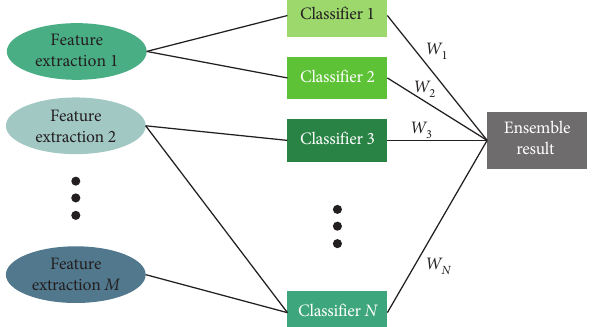
Figure 9: Improved feature extraction and classification process for achieving multiclassification task.